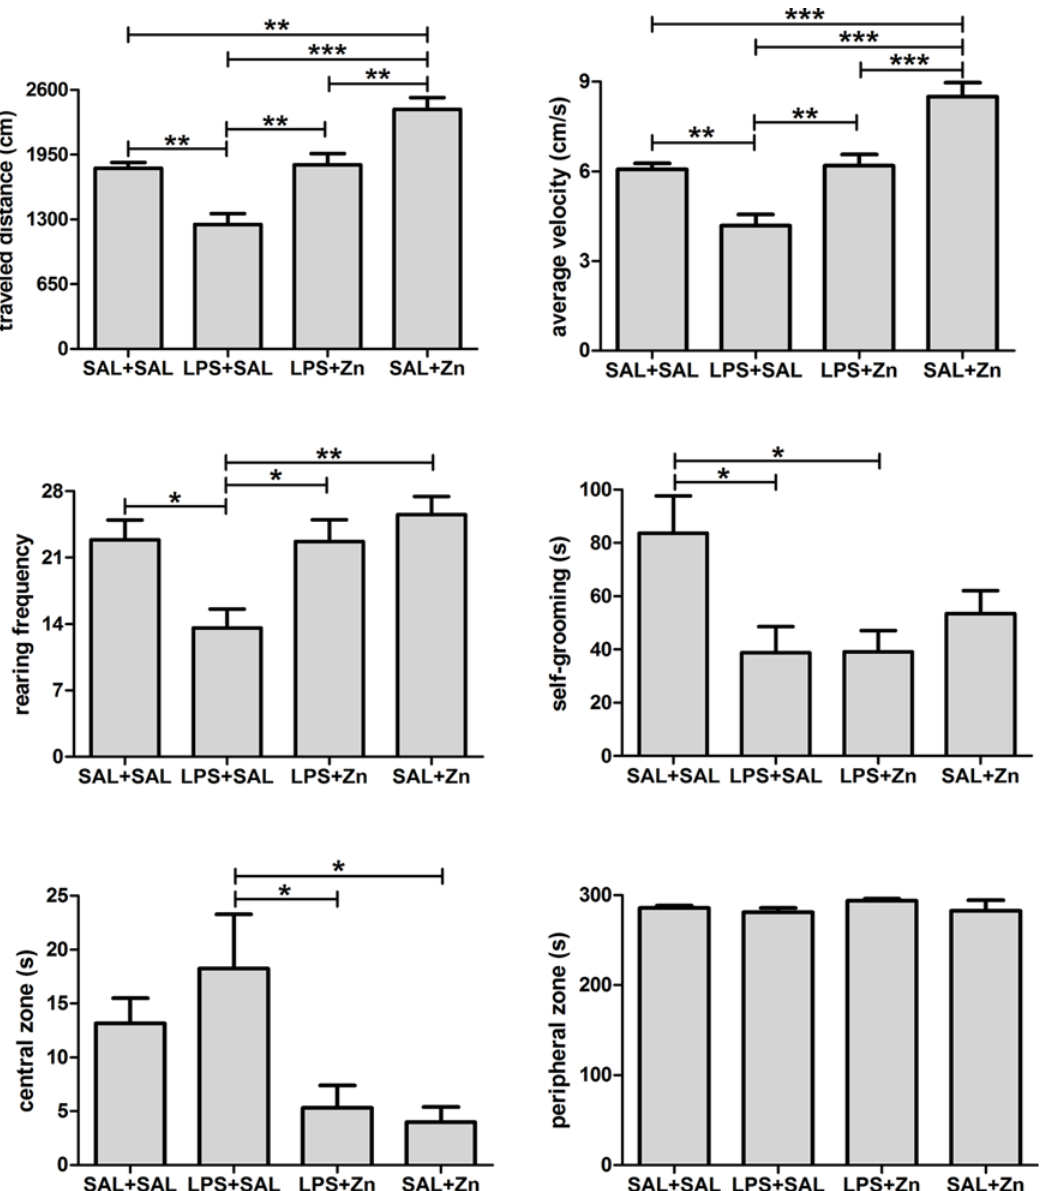
Fig 2. Open-field behavior. Effects of LPS (100 μ g/kg) and zinc (ZnSO 4 ; 2 mg/kg) on the open-field behaviors in adult male rats after a restraint stress challenge. SAL+SAL, saline injection followed by another saline injection 1 h later; LPS+SAL, LPS injection followed by a saline injection 1 h later; LPS+Zn, LPS injection followed by a zinc injection 1 h later; SAL+Zn, saline injection followed by a zinc injection 1 h later ( n = 10 per group). * p < 0.05, ** p < 0.01, *** p < 0.0001 (one-way ANOVA followed by the Tukey test). The data are expressed as the mean ±